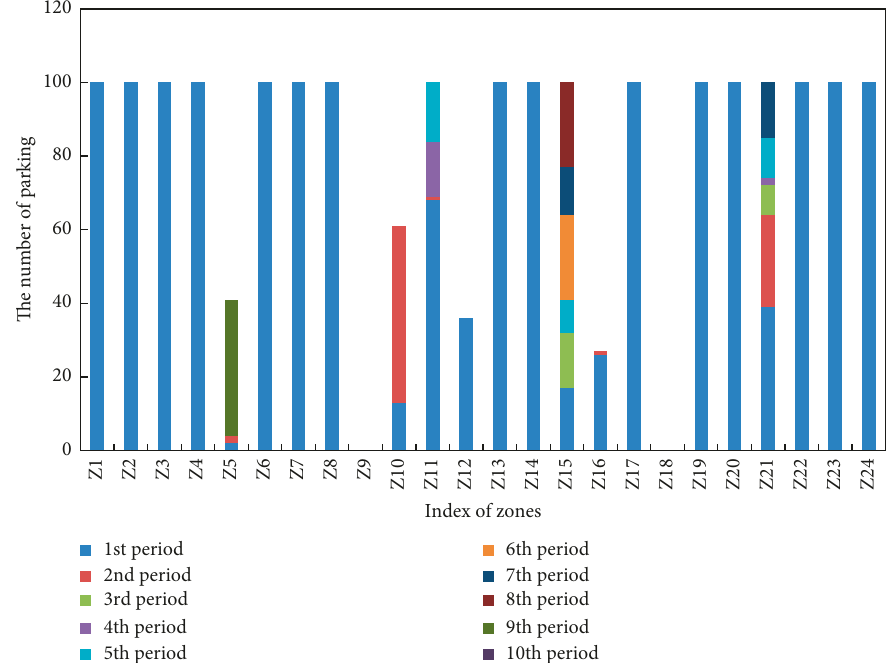
Figure 18: The number of new building parking spaces each period in each zone.